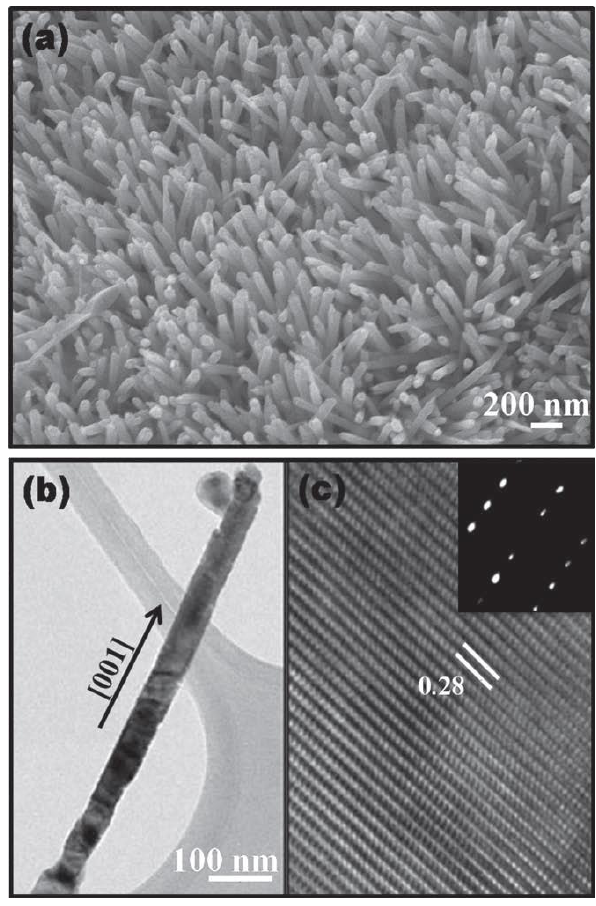
Figure 3. ( a ) Representative FESEM image of aligned ZnO nanorods; ( b ) TEM image of a single nanorod; ( c ) HRTEM image taken from the edge of the ZnO nanorod. Inset: Corresponding SAED pattern. Reprinted from [32] with permission. Copyright WILEY-VCH Verlag GmbH & Co. KGaA